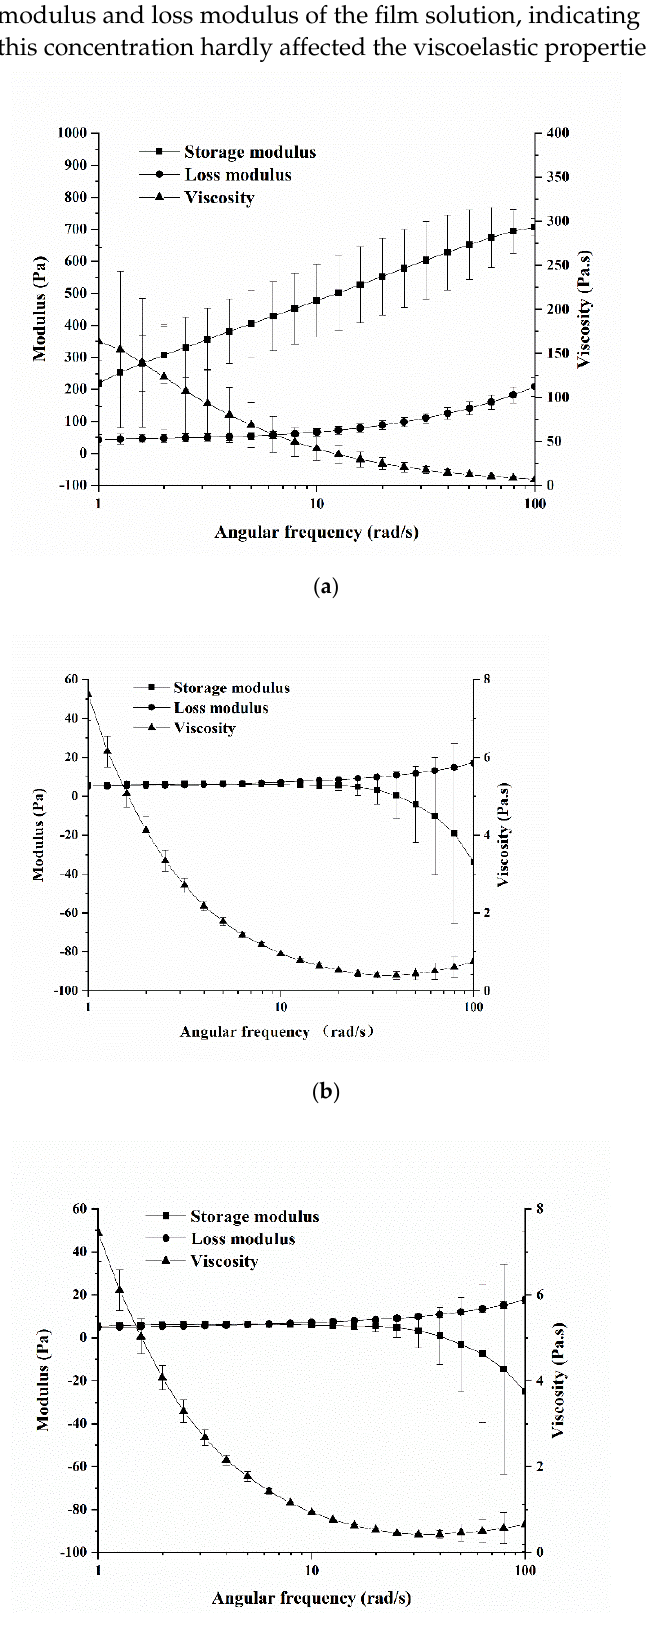
Figure 1. Rheological properties of different film solutions: ( a ) GF; ( b ) GBF; ( c ) GBMF.